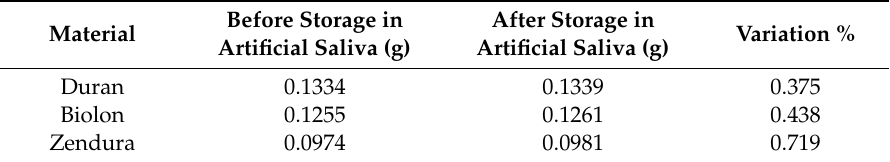
Table 3. Weight variation of material specimen due to fluid absorption, before and after storage in artificial saliva.